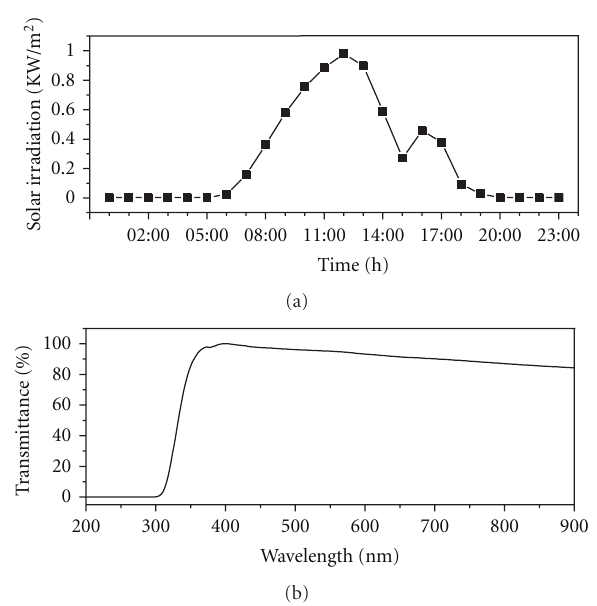
Figure 5: (a) Solar light irradiation conditions during test and (b) percentage of transmittance of the glass container.